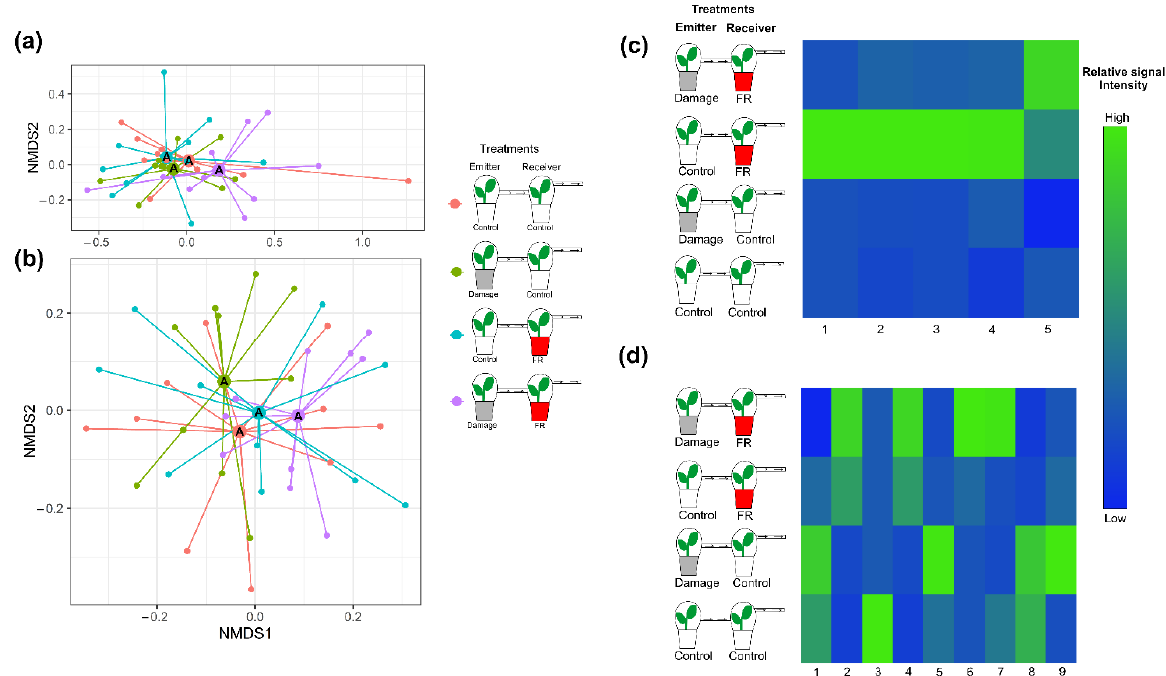
Figure 4. Plant secondary metabolite production in response to supplemented far-red (FR) light ex- posure and volatile organic compounds (VOCs) from neighbors. Plant secondary metabolite pro- duction of plants under supplemented far-red light (FR, red pots) or normal light (control, white pots) that were exposed to VOCs from control plants or plants that were damaged by two larvae of S. furgiperda (Damage, grey pots). Non-metric multidimensional scaling (NMDS) of ( a ) VOC emis- sions (stress value = 0.08728402) and ( b ) non-volatile secondary metabolite production (stress value = 0.2796113) of Solidago altissima plants under the different exposure treatments. Different letters in